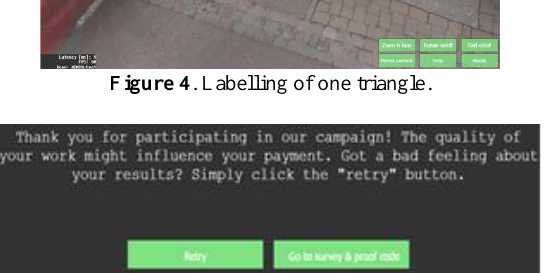
Figure 4 . Labelling of one triangle.